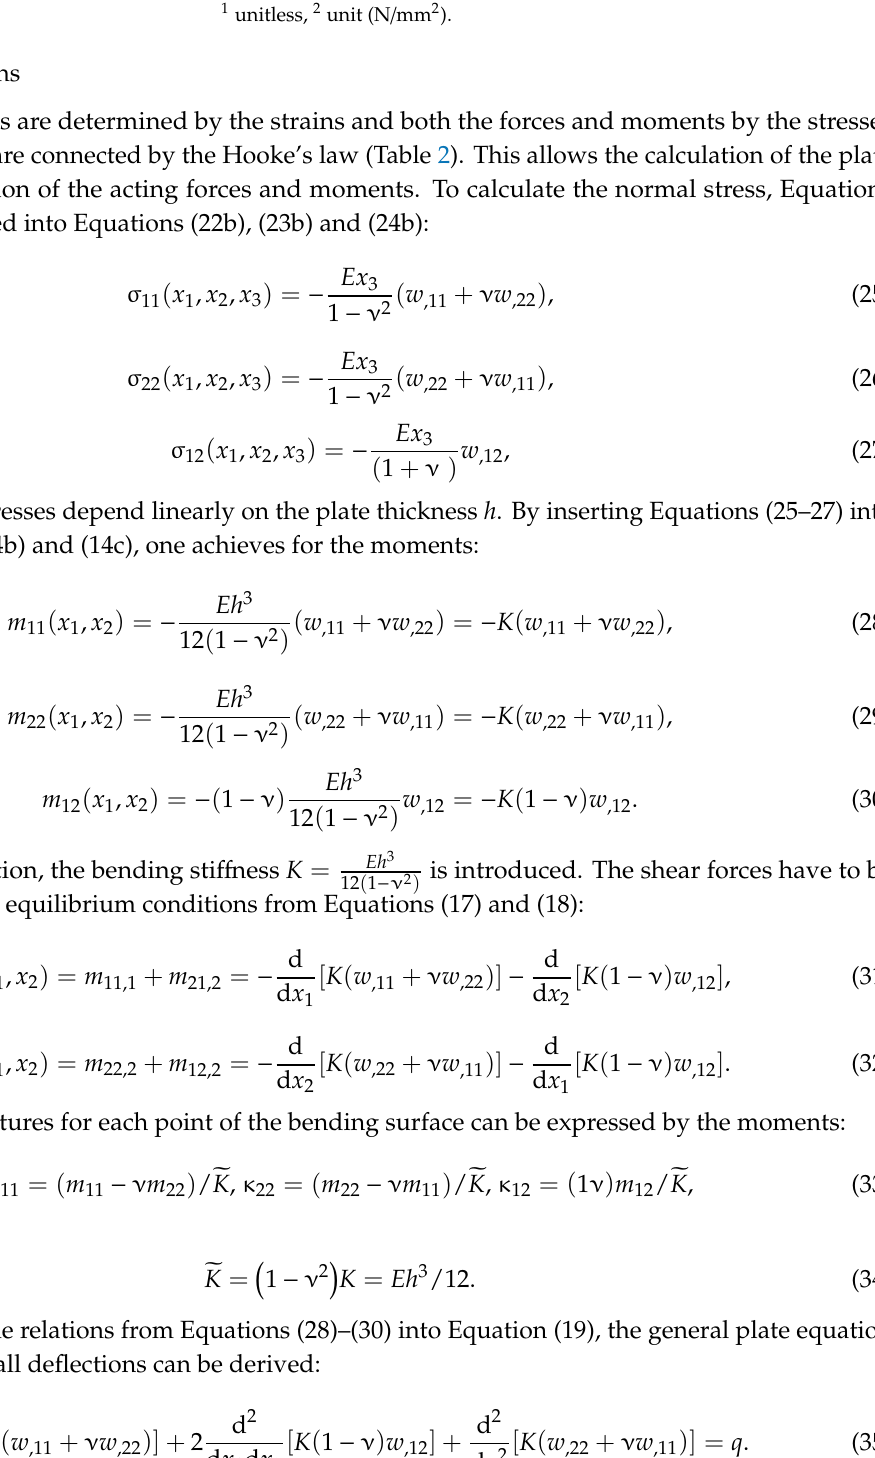
Table 2. Stress-strain relations for fully elastic material behavior ( E Young’s modulus, ν Poisson’s ratio). Quantity Strains 1 Stresses 2 Normal components Shear